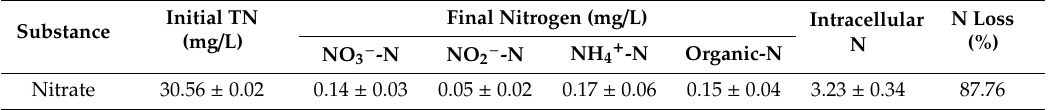
Note: N loss = (Initial TN–Final N–Intracellular N) / Initial TN *